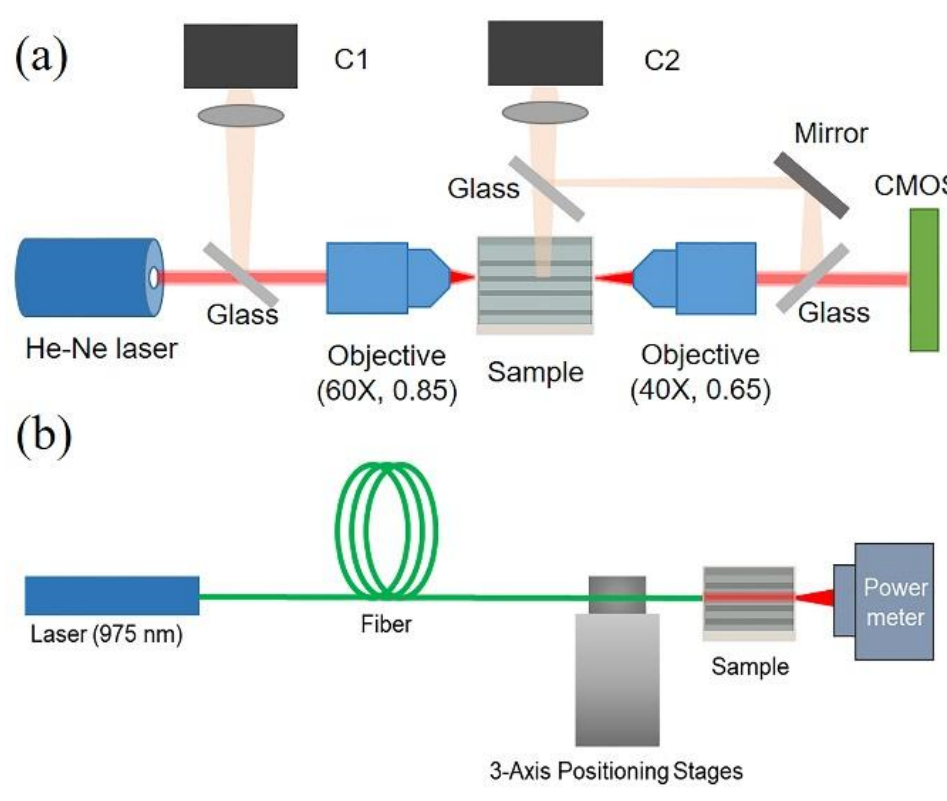
Figure 1. Schemes of the experimental setups for the caption of near-field intensity distribution ( a ) and for measuring losses of waveguides ( b ).